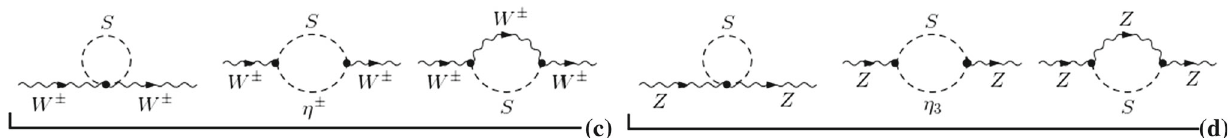
Fig. 9 c S field contributions to the W boson self energies; d S field contributions to the Z boson self